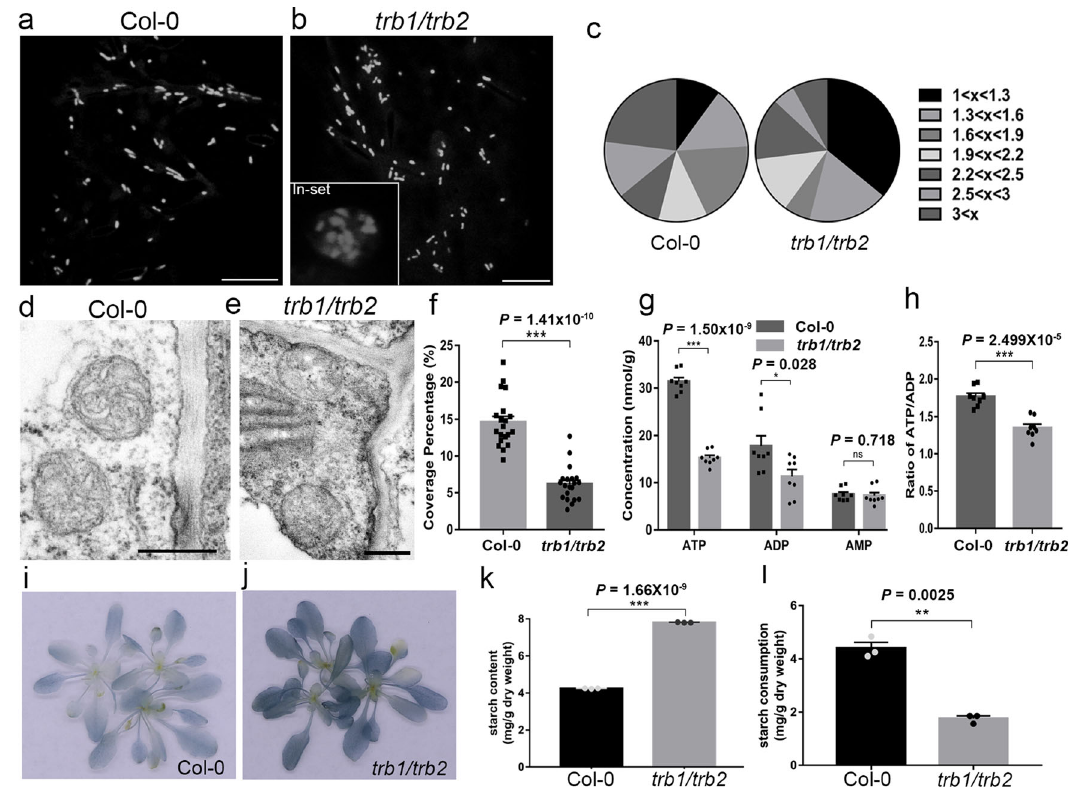
Fig. 4 | TraB family proteins are essential for normal mitochondrial structure andenergymetabolism.a – c Inthe trb1/trb2 T-DNAmutantArabidopsislinestably expressingMito-mCherry,themorphologyofmitochondriaissigni fi cantlyaltered, as indicated by the increased population of circular mitochondria (aspec ratio at 1-1.3, c ).Mitochondrialaggregations( b ,inset)werealsofrequentlyobserved.Inthe trb1/trb2 Arabidopsis, mitochondrial structures are also disrupted at the ultra- structurallevel( e );theirinternalmembranecisternaearemorefragmentedandthe matrixbecomesmoreelectron-transparentcomparedwiththatinthewildtype( d ). f Quanti fi cationofthemitochondrialcristaecoverageof trb1/trb2 mutantandwild- type Arabidopsis. The levels of ATP, ADP and AMP are all signi fi cantly reduced in the trb1/trb2 mutant( g ),andtheATP/ADPratioisalsolowerinthemutant( h ),both results suggested a disruption in energy metabolism and mitochondrial